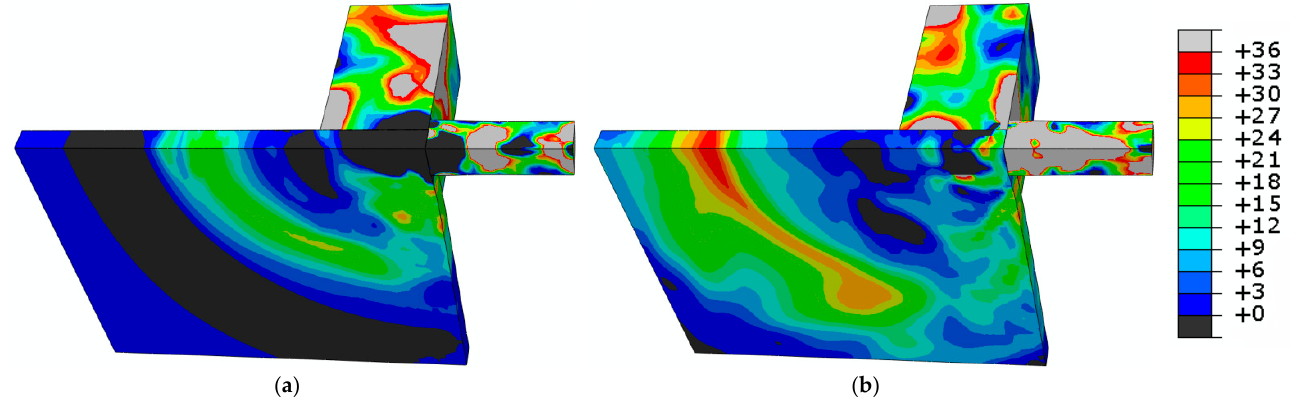
Figure 12. Field of first principle stress in [MPa] ( a ) T = 20 µs and ( b ) T = 40 µs.